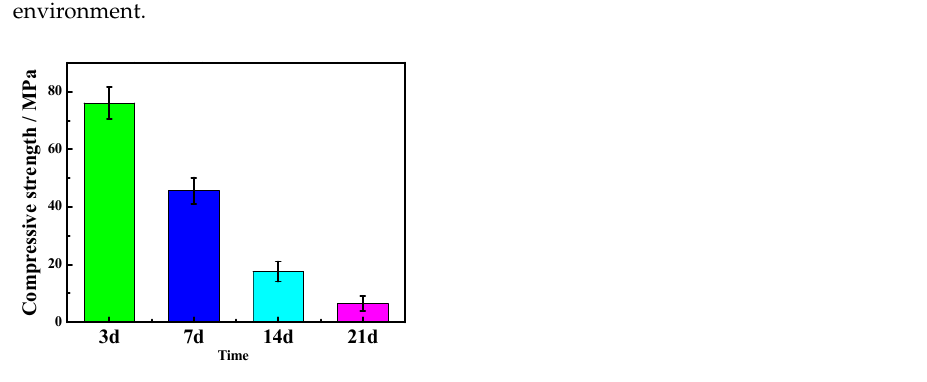
Figure 17. Compressive strength of the MOC specimens immersed in water for different times. 10 mm. When sample “c” is immersed in water for 7 days once more, reaction (5) and P 5. This results in the gel state and short, rod ‐ like morphology becoming a micro ‐ flake